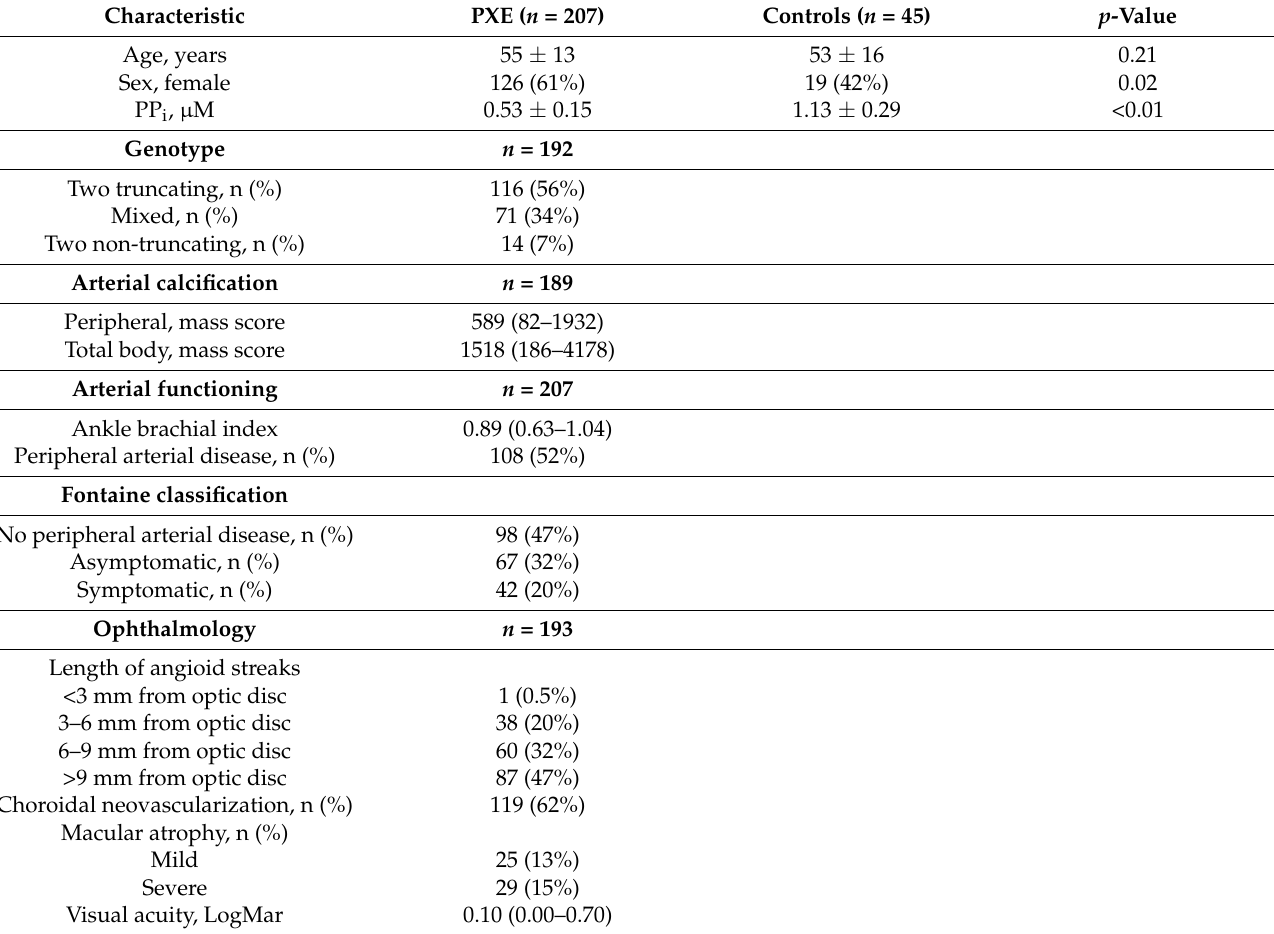
Table 1. Patient